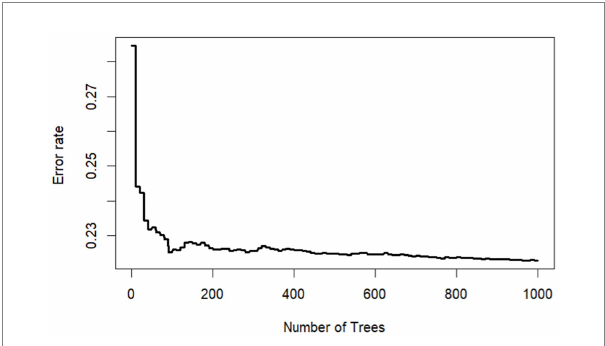
FIGURE 1 Model prediction error rate for different number of survival trees.